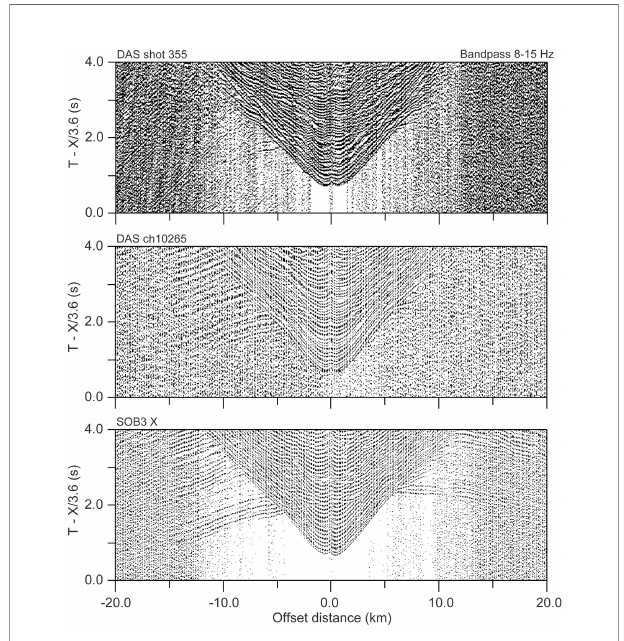
FIGURE 12 | Comparison of time – distance pro fi les obtained by the accelerometer and DAS. The DAS pro fi les of both the common shot gather and the common receiver gather are shown. The SOB3 pro fi le is the common receiver gather. The X-component of the records is shown for the accelerometer in the SOB3. The data were bandpass- fi ltered to increase the S/N ratios. For the DAS pro fi le, the data were displayed every 10 channels, and the adjacent 11 channels were averaged. The positions of the shot number of 355 and a channel of 10265 in the DAS records were estimated to be close to the accelerometer. Although the P-wave arrivals on the DAS records have small amplitudes, both pro fi les have similar features.